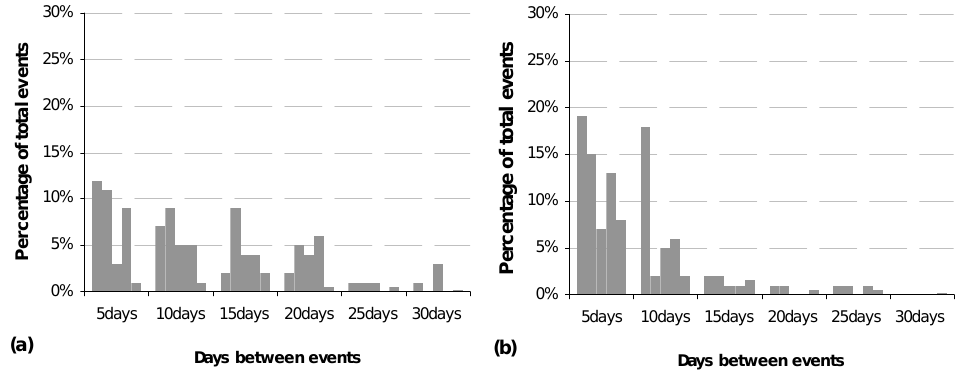
Inter-arrival time distribution of credit losses for banks using the AA for the period (a) January 2003 to June 2007 and (b) July 2007 to July